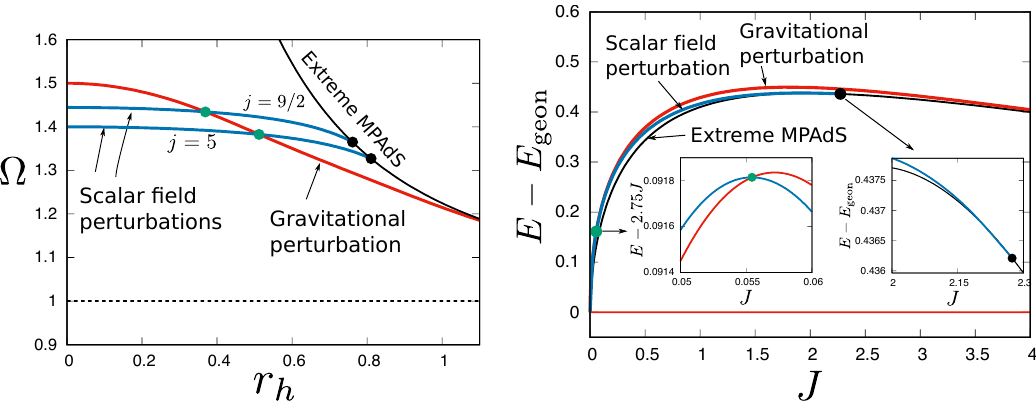
Figure 2 . (Left) Onset of the superradiant instability of MPAdS against gravitational perturbation (red) and scalar field perturbations with j = k = 9 / 2 , 5 (blue) in the (Ω , r ) -plane. Above the red h and blue curves, MPAdS is unstable to gravitational and scalar perturbations, respectively. The extreme limit of MPAdS is shown by the black curve. (Right) The same data as the left panel are shown in the ( E − E ) -plane, though for the scalar field perturbations only the onset of the geon , J mode with j = k = 9 / 2 is shown for